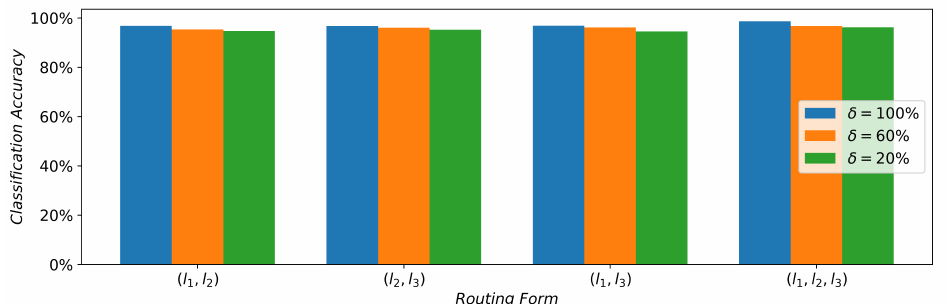
Figure 7. Classification accuracy with different routing forms and tracking